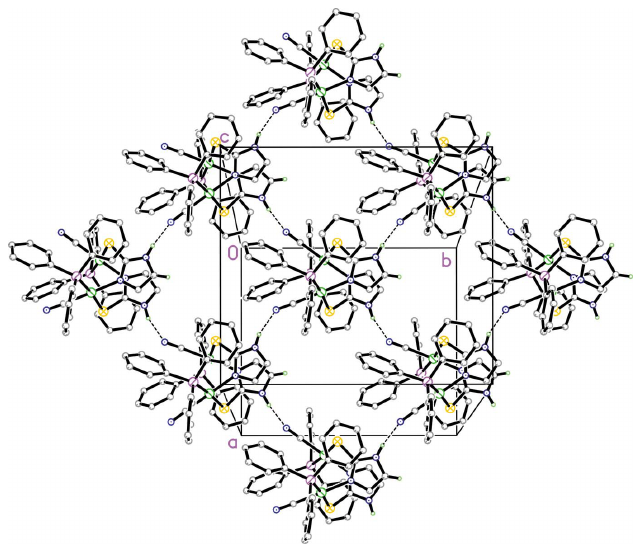
Figure 4 Diagram showing the packing for 2 showing the two intermolecular C 1 N—H (cid:2)(cid:2)(cid:2) N hydrogen bonding chains in the [110] and [ 110] directions. Hydrogen atoms not involved in hydrogen bonding are omitted for clarity.